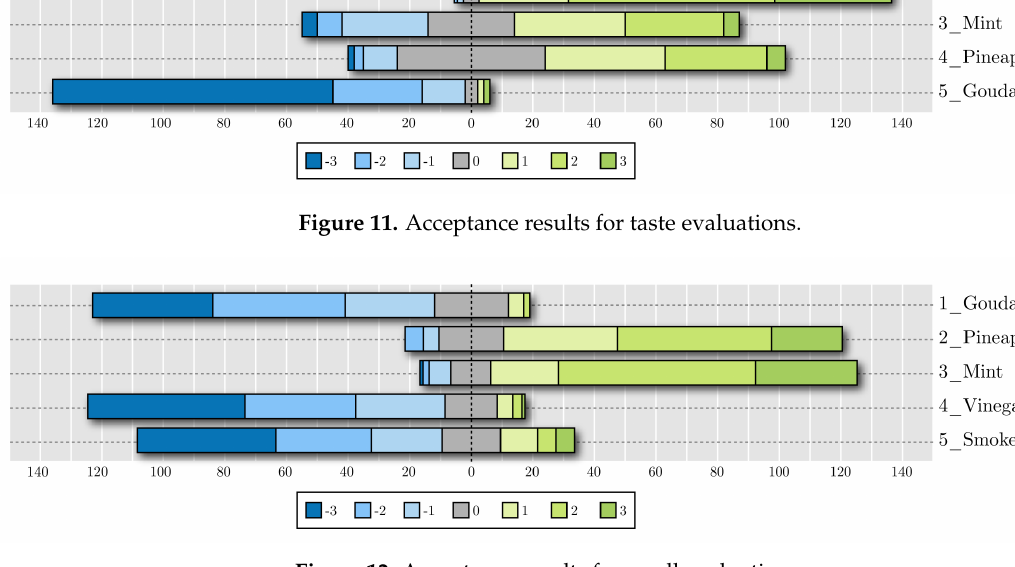
Figure 12. Acceptance results for smell evaluations.